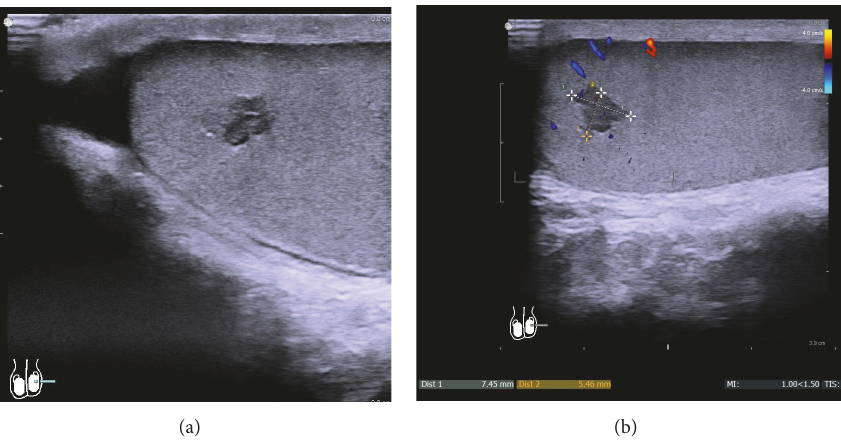
Figure 1: (a) Sonographic appearance of the adult granulosa cell tumor in the 22-year-old patient. Note the lobulated but well circumscribed shape and homogeneous hypoechoic appearance. (b) The same patient, color-coded duplex sonography showing duplex signals within the hypoechoic lesion.